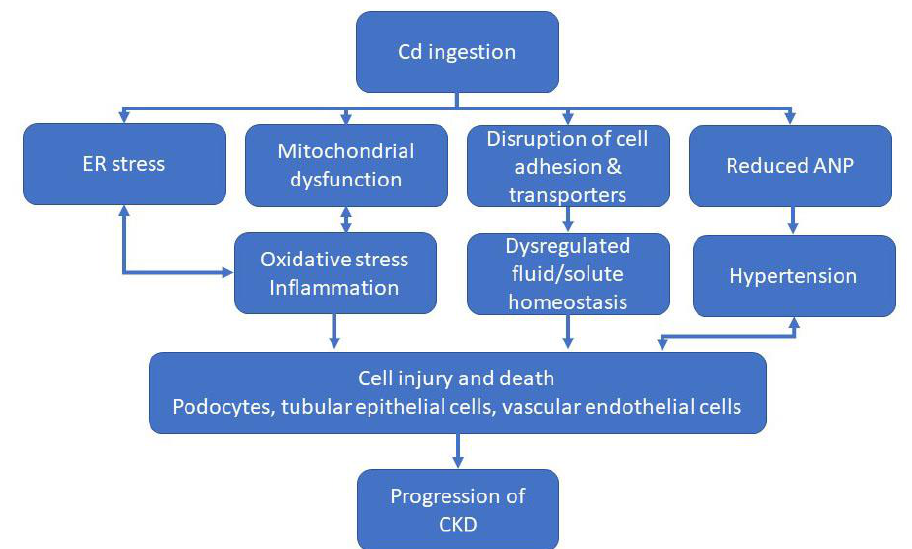
Figure 4. Schematic to summarize major factors that contribute to progression of CKD following exposure to cadmium (Cd). Additional factors not included here also contribute to Cd-induced progression of CKD.